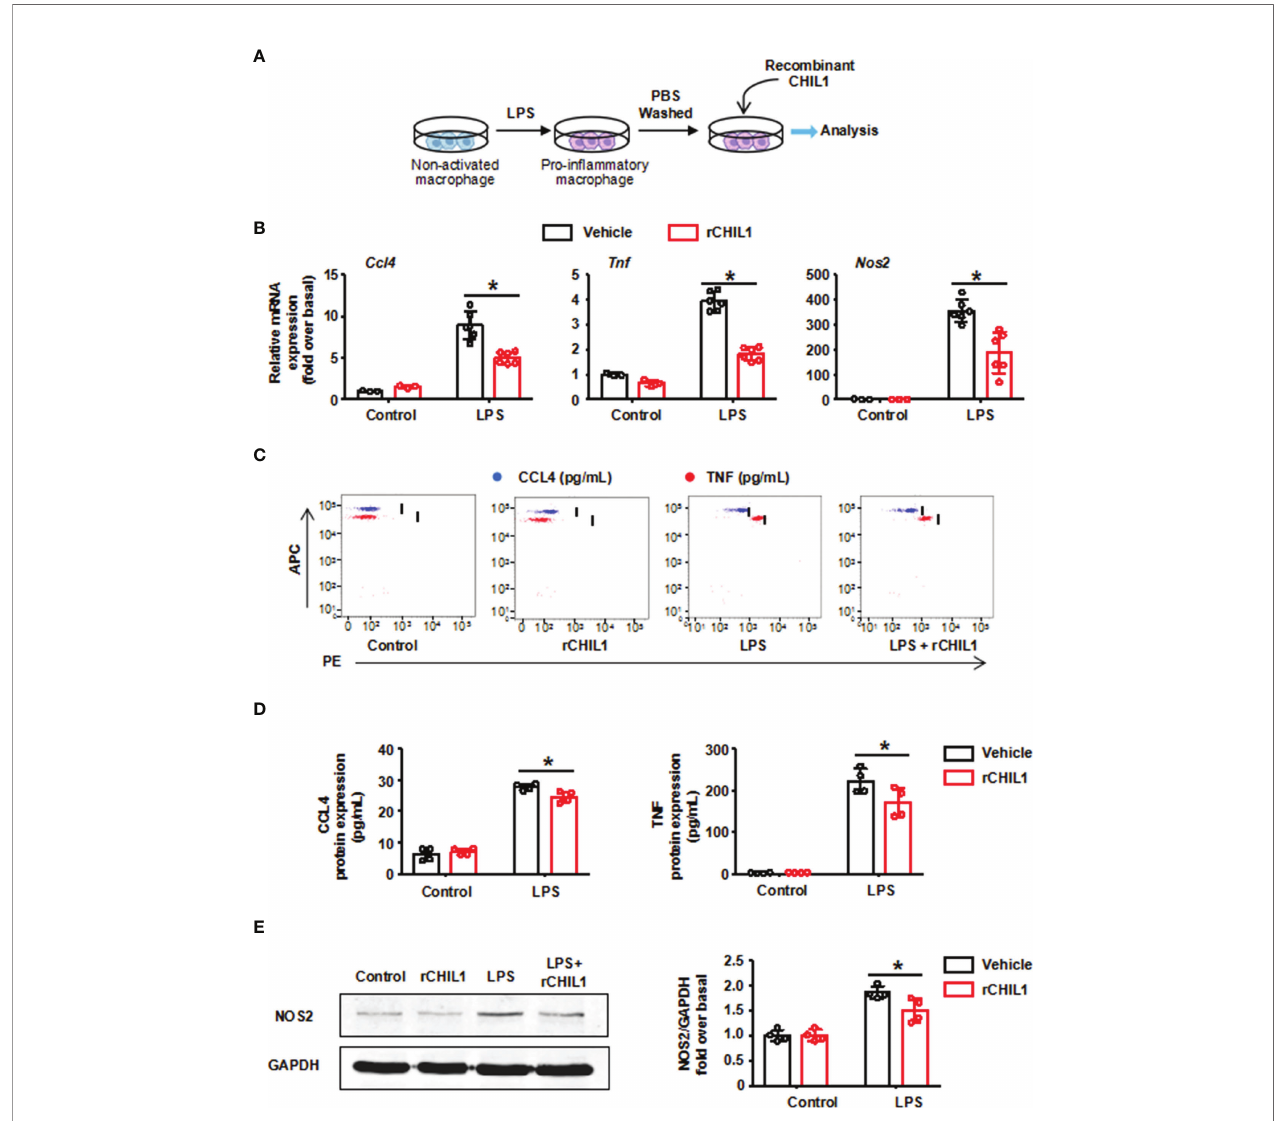
FIGURE 6 | Recombinant CHIL1 inhibited the pro-in fl ammatory phenotype of macrophages. (A) Schematic representation of the experimental design: bone marrow-derived macrophages were stimulated with LPS 10 ng/mL for 3 hours, washed with PBS, and then treated with Vehicle (PBS) or rCHIL1 (100 ng/mL) for 24 hours respectively. (B) Macrophages were harvested and the mRNA expression levels of genes Ccl4 , Tnf and Nos2 were evaluated using RT-qPCR, presented relative to Gapdh , (control group, n=3; LPS group, n=6). The protein expressions of CCL4, TNF and NOS2 in liver were detected by CBA (C, D) and WB (E) n=4. The results were presented as mean ± SD. Two-way ANOVA was used. *P < 0.05. rCHIL1, Recombinant CHIL1; Ccl4, C-C chemokine motif ligand 4; Tnf, tumor necrosis factor; Nos2, nitric oxide synthase 2; LPS,